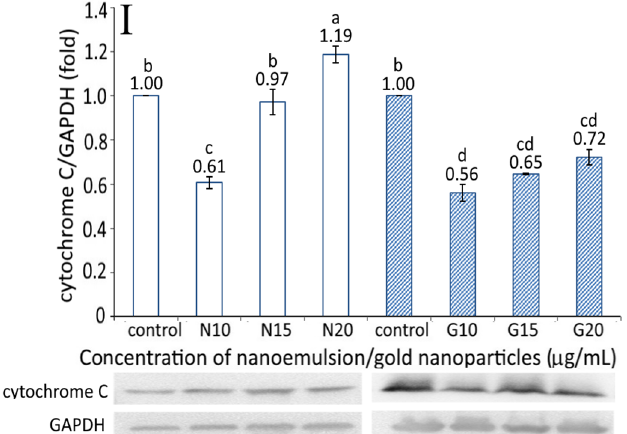
Figure 6. Effect of different concentrations (10, 15, and 20 µg/mL) of resveratrol nanoemulsion (N) and resveratrol-gold nanoparticles (G) on cyclin A ( A ), cyclin B ( B ), CDK1 ( C ), CDK2 ( D ), Bax ( E ), BcL-2 ( F ), p53 ( G ), p21 ( H ), and cytochrome C (I) expressions in pancreatic cancer cells BxPC-3. Control represents that cells were incubated in RPMI medium containing blank nanoemulsion without resveratrol ( ) and gold nanoparticles without resveratrol ( ). Data are shown as mean standard deviation ( n = 3) and data with different small letters (a–e) are significantly different at p < 0.05.